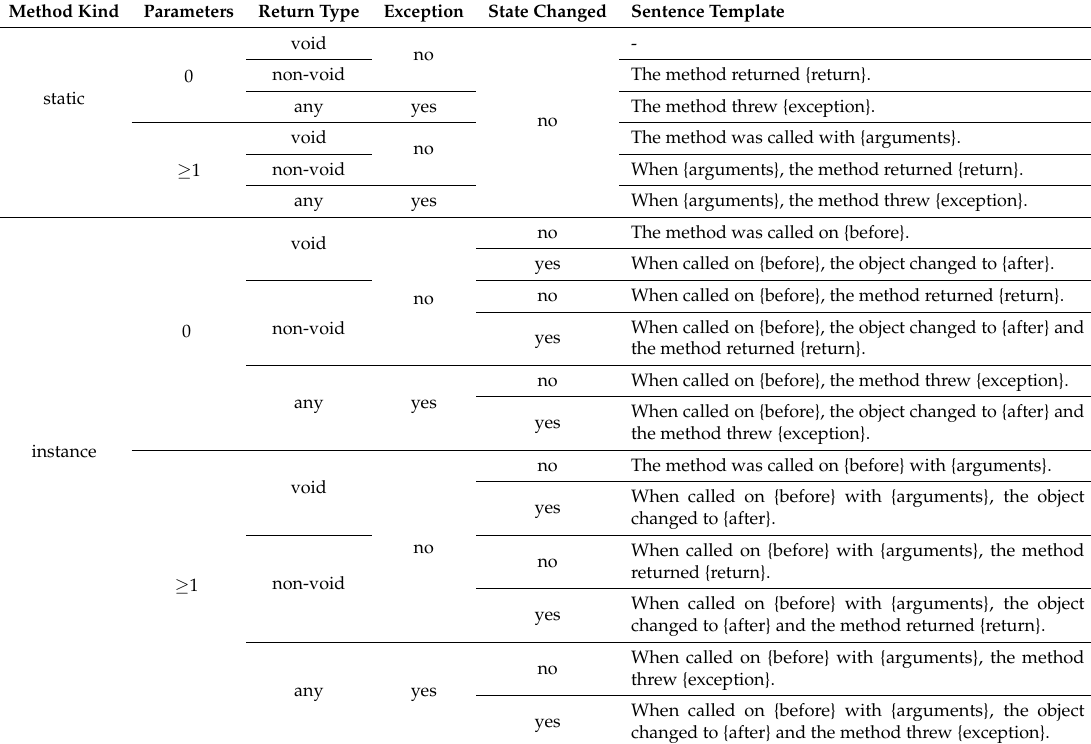
Table 1. A decision table for the documentation sentence